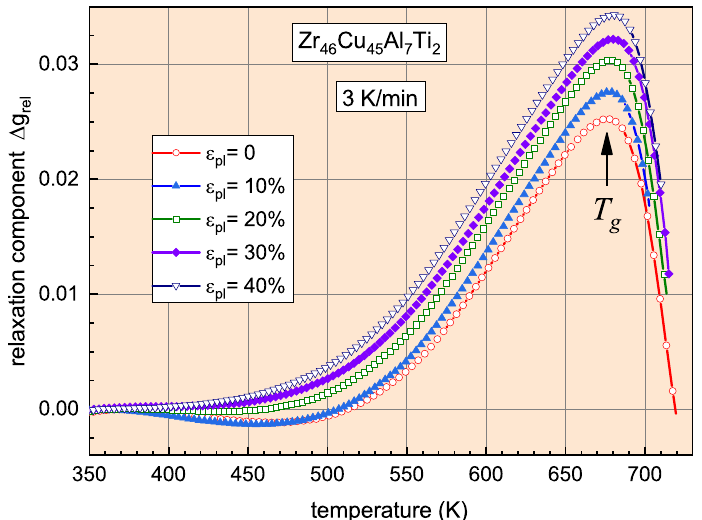
Figure 3. Temperature dependences of the relaxation component of the normalized shear modulus of bulk glassy Zr 46 Cu 45 Al 7 Ti 2 in the undeformed state ( ε pl = 0) and after deformation by different ε pl as indicated. The error is about the symbols’